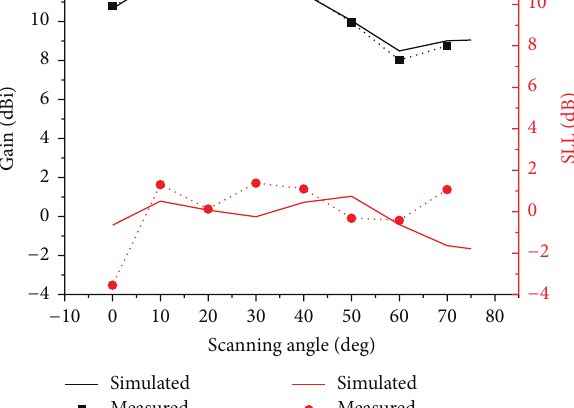
− 10 dB below the maximum of the main beam. The 3 dB beam-width coverage is − 86 ∘ ∼ 86 ∘ , which means that this novel symmetric thinned antenna array can realize the entire upper-space beam coverage and restrain the SLL at the same time.